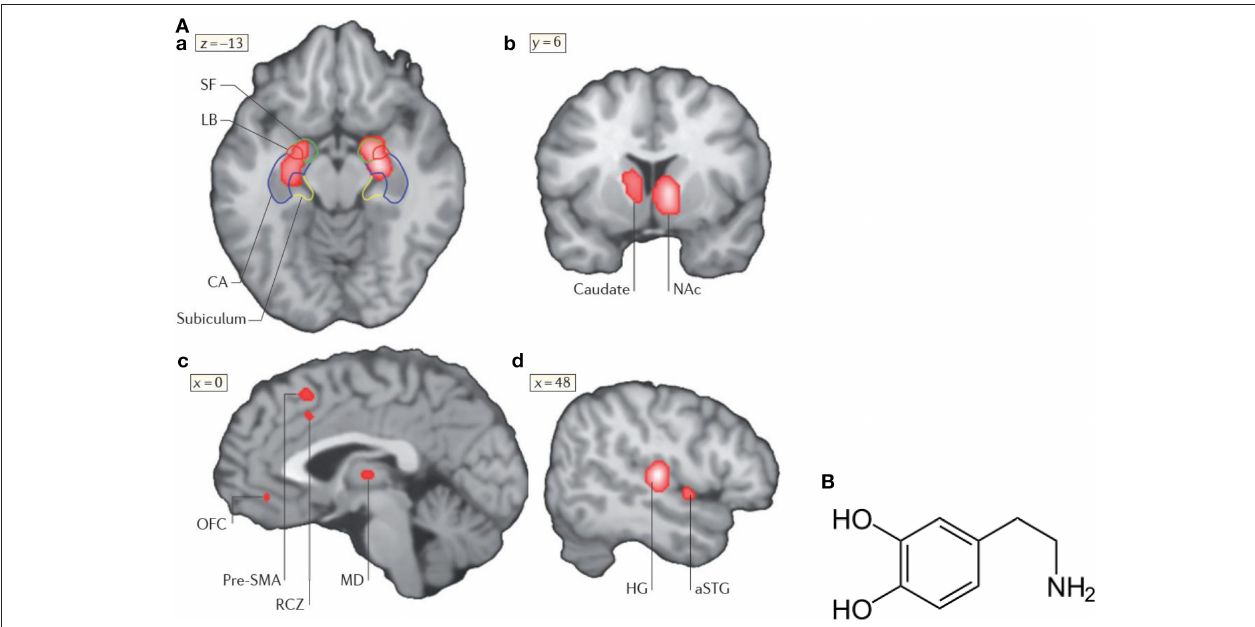
FIGURE 6 | (A) Neural correlates of music-evoked emotions. A meta-analysis of brain-imaging studies that shows neural correlates of music-evoked emotions. A meta-analysis is a statistical analysis of a lager set of the analyses of earlier data. The meta -analysis indicates clusters of activities derived from numerous studies (for references see Koelsch, 2014) in the amygdala (SF, LB), the hippocampal formation (a), the left caudate nucleus with a maximum in the nucleus accumbens (NAc, b), pre-supplementary motor area (SMA), rostral cingulated zone (RCZ), orbifrontal cortex (OFC), and mediodorsal thalamus (MD, c), as well as in auditory regions (Heschls gyrus HG) and anterior superior temporal gyrus (aSTG, d). Additional limbic and paralimbic brain areas may contribute to music-evoked emotions. For details see Koelsch (2014). Reprinted with permission from Koelsch (2014) © 2014 Nature Publishing Group. (B) Structural formula of dopamine (http://de.wikipedia.org/wiki/ Dopamin)